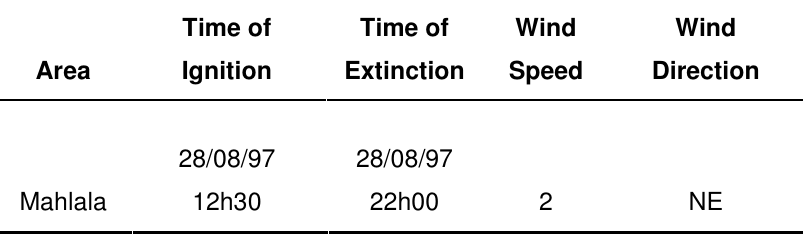
Table 3. Selected information from the fire record for Mahlala area of